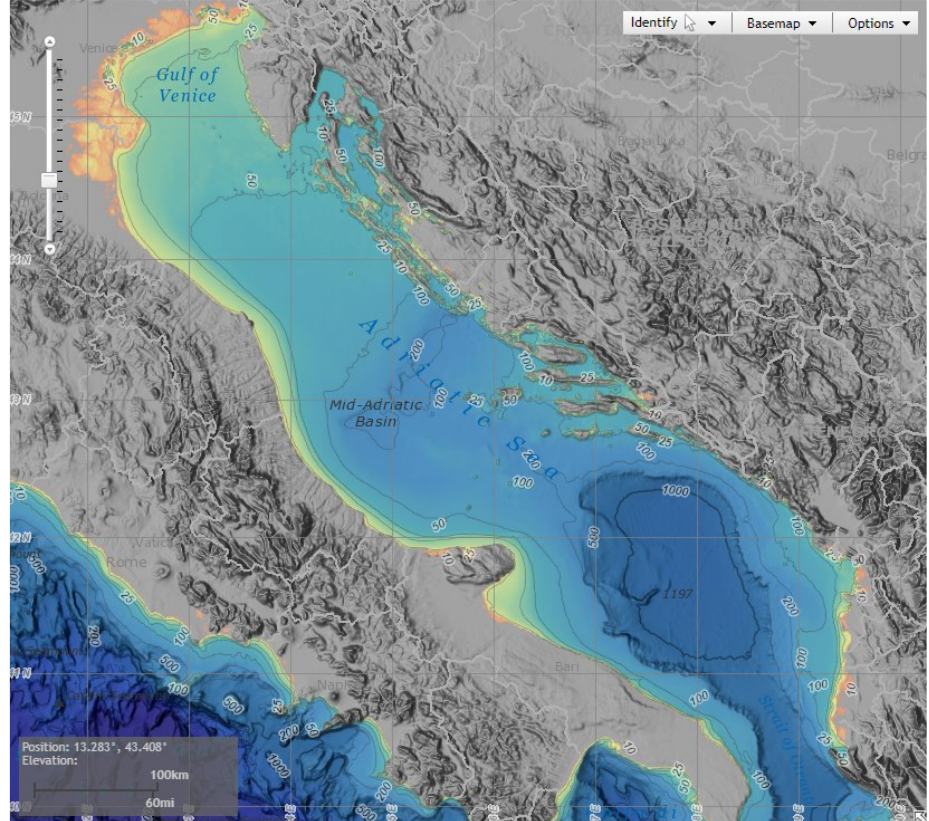
Figure 1. The Adriatic Sea is located in the central-north part of the Mediterranean Sea. Surrounded by the mountain ranges Apennine in the west and Dinaric in the east, the basin stretches for more than 800 km from the shallower northwest to the deeper southeast, where the Strait of Otranto connects with the rest of the Mediterranean Sea. Depth contours or isobaths outline basin bathymetry offering an insight into seafloor terrain—source: https://maps.ngdc.noaa.gov/viewers/bathymetry/ (accessed on 30 November